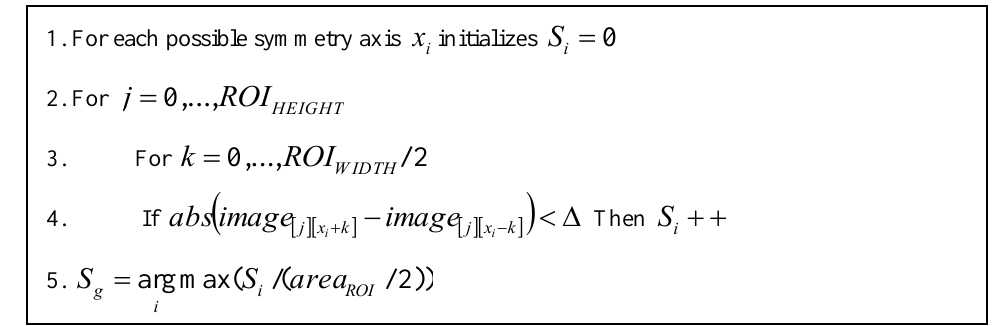
Figure 7. Gray level symmetry computation procedure.